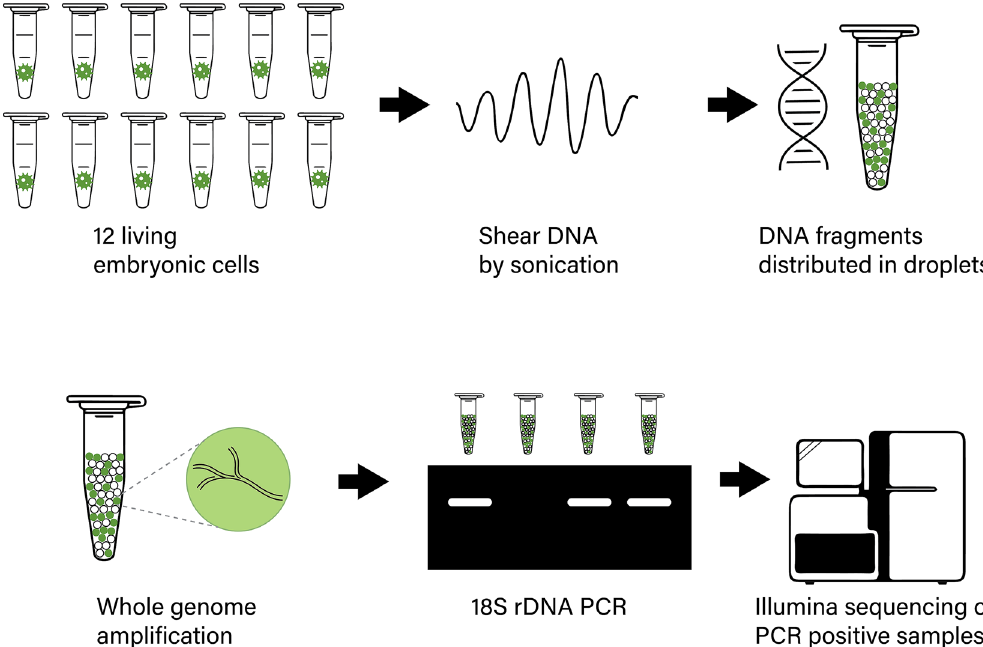
Figure 1. Schematic overview of the wet-lab procedure. 12 individual embryonic cells of A. acetabulum were isolated individually. The genomic DNA of the cells was shared using sonication before the DNA and